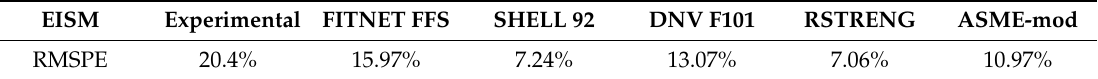
Table 2. Summary of the Root Mean Square Percentage Error (RMSPE) of X46 and X52 grade pipes’ FEM-estimated burst pressures compared with the experimental and industry standard models (EISM) estimations.